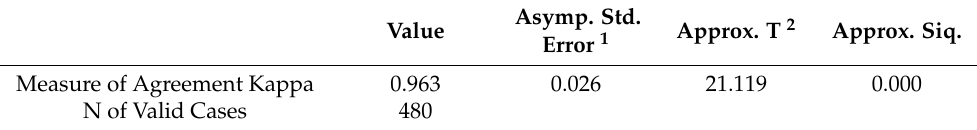
Table 6. Symmetric measures of RT-qPCR off-chip and on-chip on 40 clinical samples.